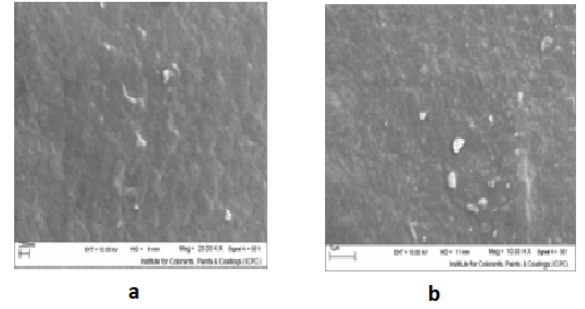
Figure 6. Scanning electron micrographs of PAI- nanocomposite films 4a (a) and 4b (b).